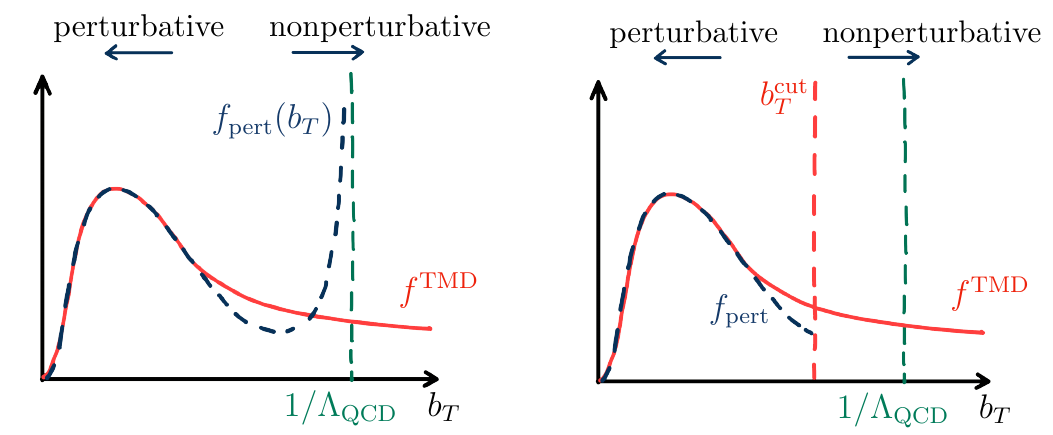
Figure 1 . Left: a perturbative calculation of the TMD PDF (dashed blue) blows up at the Landau pole µ ∼ 1 /b T ∼ Λ QCD . Right: in our construction in this paper, we introduce a cutoff on the Fourier integral at b cut , below which the perturbative calculation is still a good approximation of the full T TMD PDF (red). We then show that by supplementing the result with higher-order contact terms on the boundary, a purely perturbative baseline for the Fourier transform at transverse momenta | ~k T | (cid:29) Λ QCD can be computed and systematically supplemented by higher-order nonperturbative